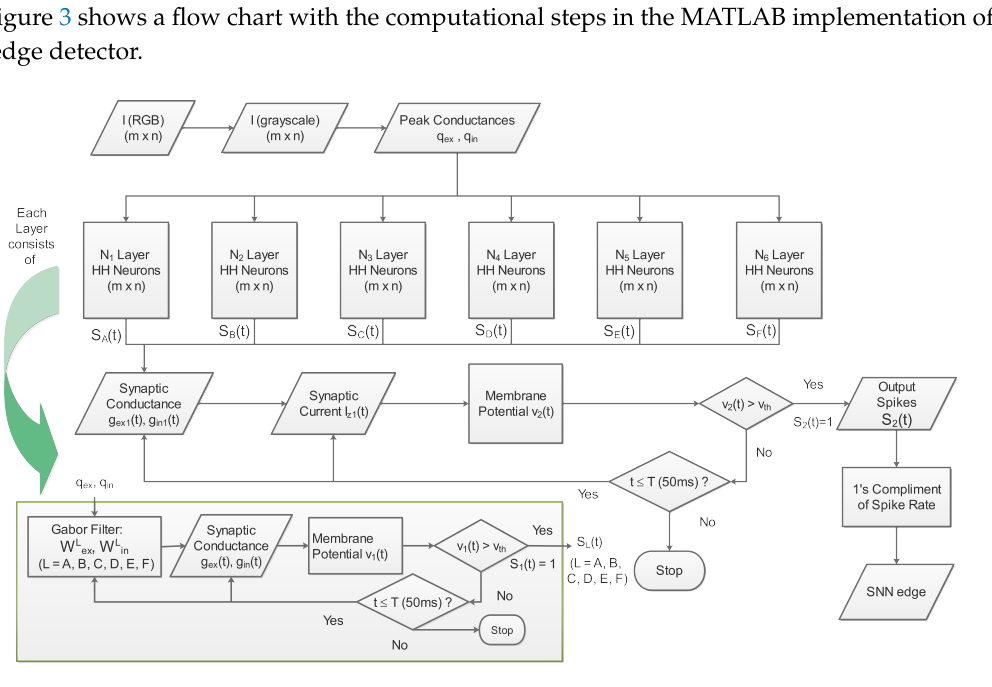
Figure 3. Flow chart showing the computational steps for the implementation of the Spiking Neural Network (SNN) edge detector in MATLAB with I as the input image of m × n